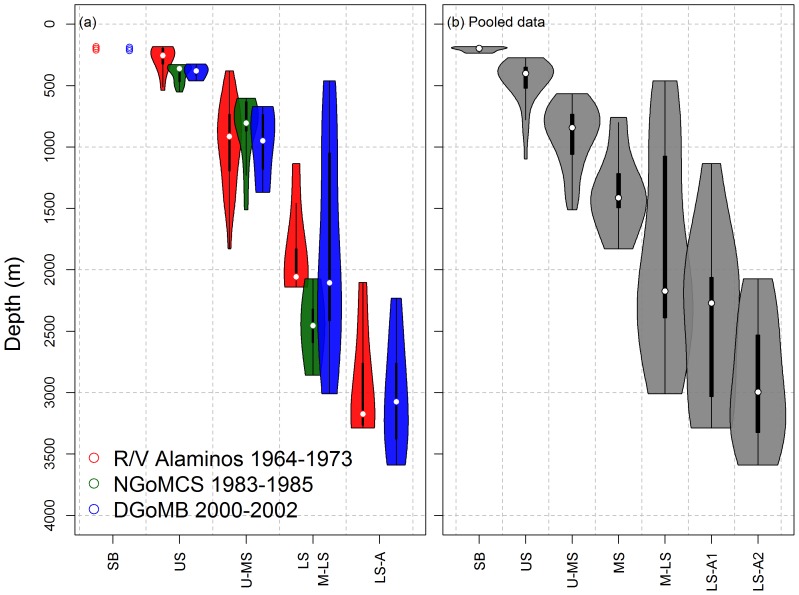
Violin plots of sampling depths for homogenous faunal groups in (a) R/V Alaminos, NGoMCS, and DGoMB studies, and (b) pooled data of all three studies.The violin plot is a combination of box plot and kernel density plot, which started with a standard box plot (with minimum, lower quartile, median, upper quartile, and maximum depth values) and then added rotating kernel density plots to each side of the box plot. When the sampling depths were equal or less than three observations, the raw depth values were shown directly.